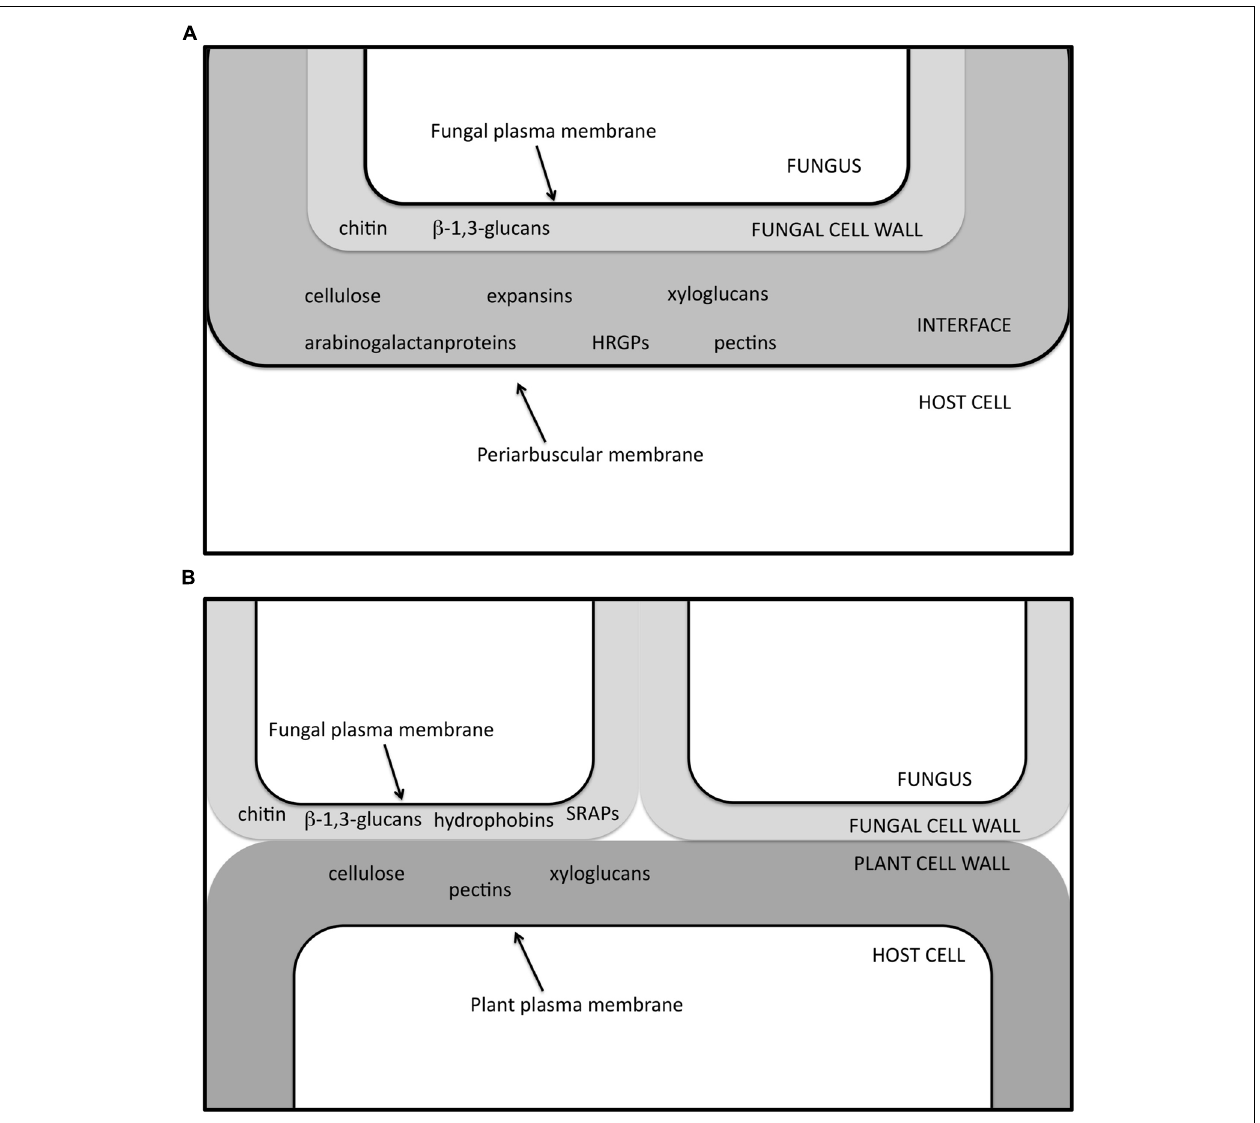
FIGURE 3 | Schematic view of the interface zone inAM (A) and ECM (B) symbiosis, in which several of the molecules so far determined through in situ labeling experiments (Balestrini etal., 1996a,b; Laurent etal., 1999;Tagu etal., 2001; Balestrini and Bonfante, 2005) are listed. HRGPs, hydroxyproline-rich glycoprotein; SRAPs, symbiosis-regulated acidic